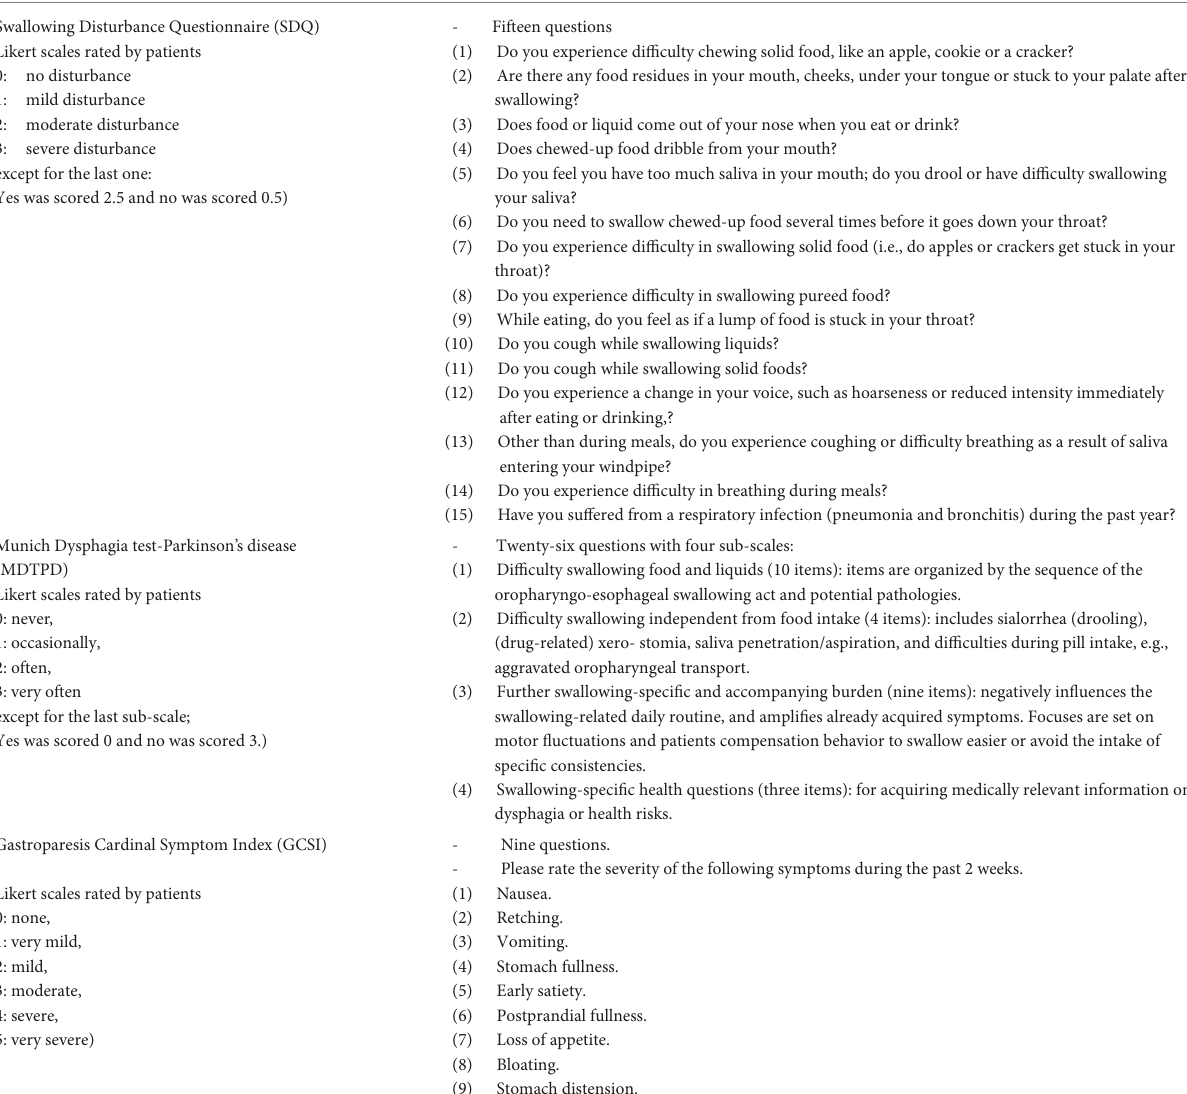
TABLE 2 Validated questionnaires for upper GI tract evaluation. Scales Components Swallowing Disturbance Questionnaire (SDQ) Likert scales rated by patients